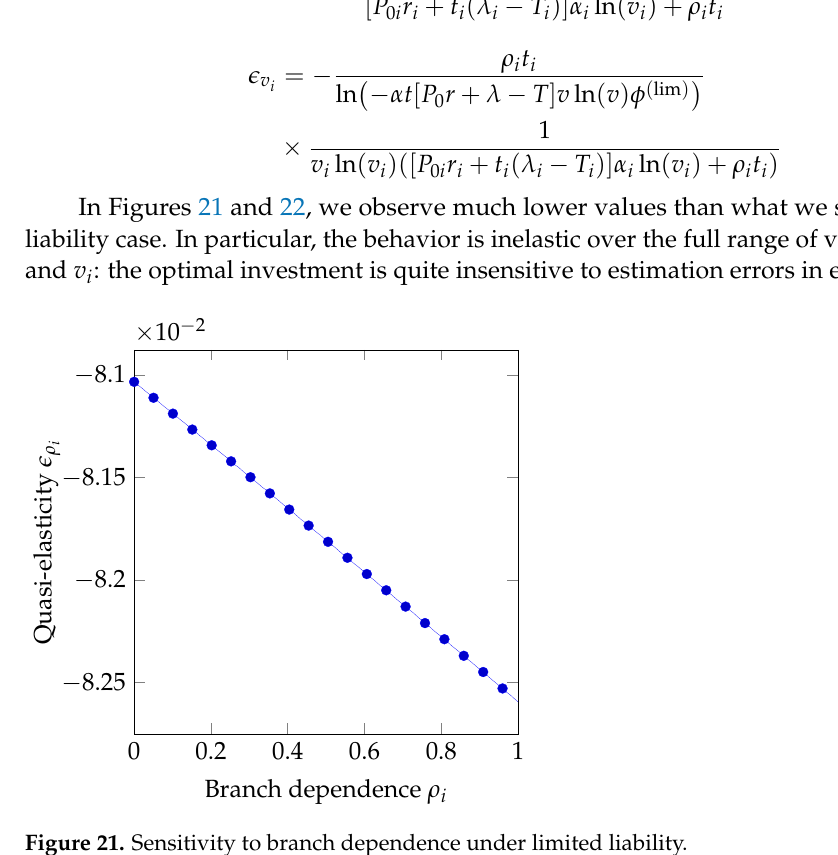
Figure 21. Sensitivity to branch dependence under limited